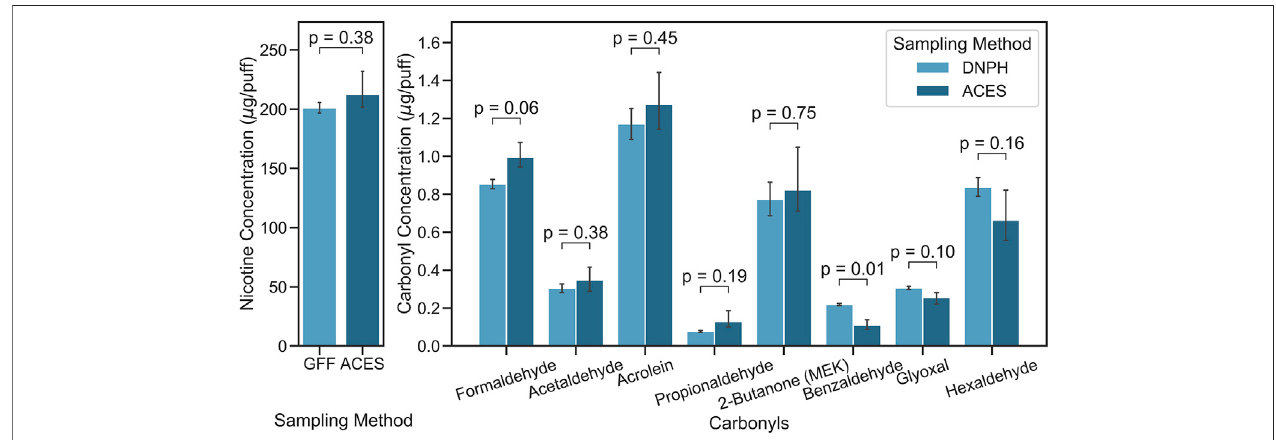
FIGURE2| E-cigarettenicotineandcarbonylemissionlevelsmeasuredusingtheconventionalmethods[glass fi ber fi lter(GFF)orDNPH- fi ler/cartridge(DNPH)]and the E-cigarette Aerosol Collection and Extraction System